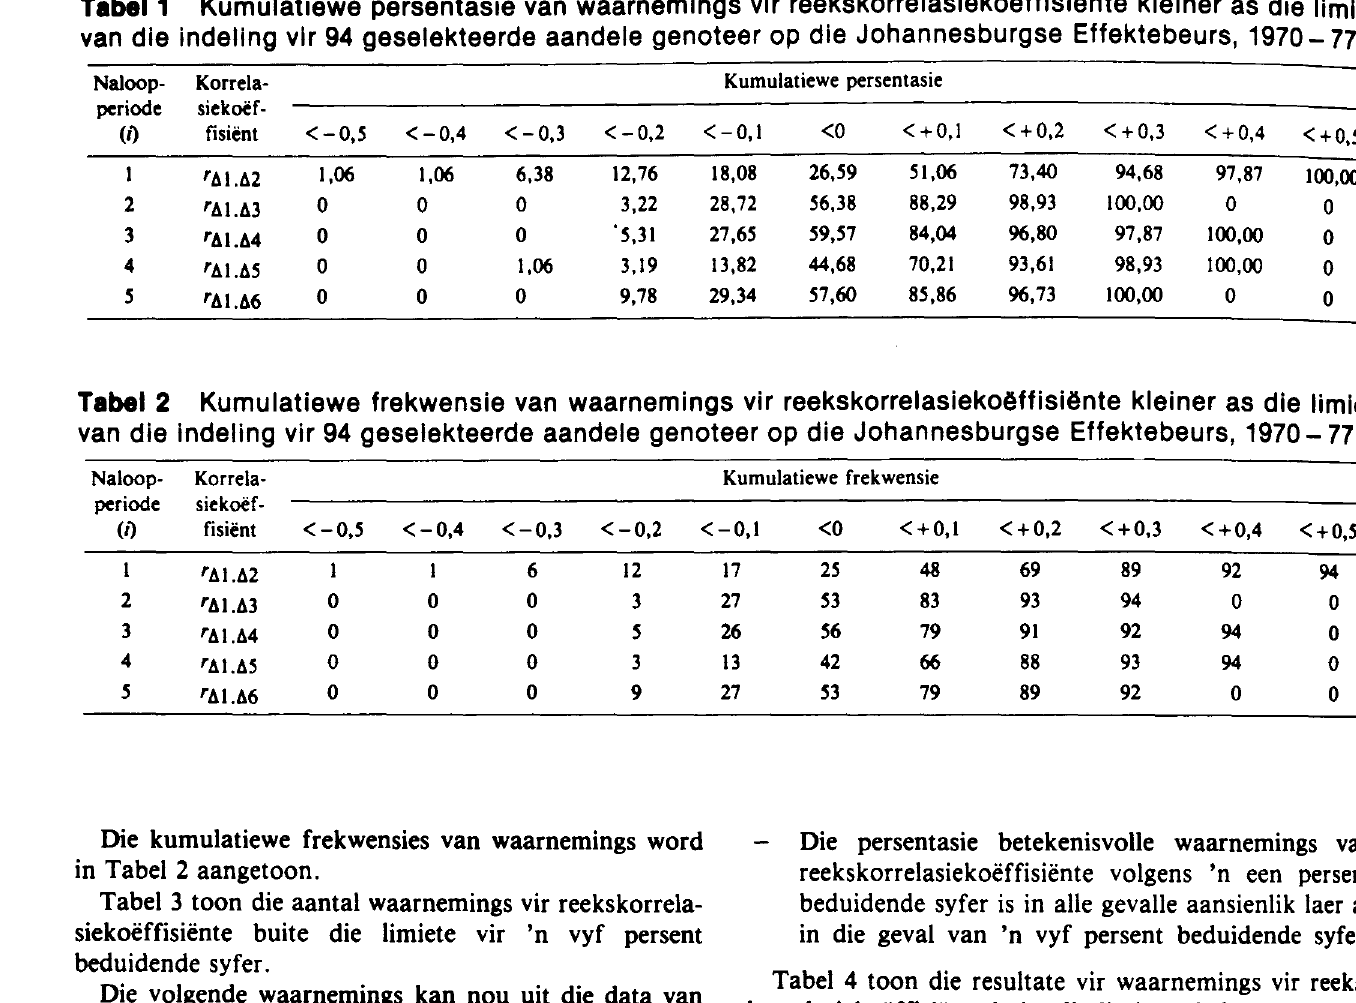
Tabel 3 toon die aantal waarnemings vir reekskorrela siekoeffisiente buite die limiete vir 'n vyf persent beduidende syfer.